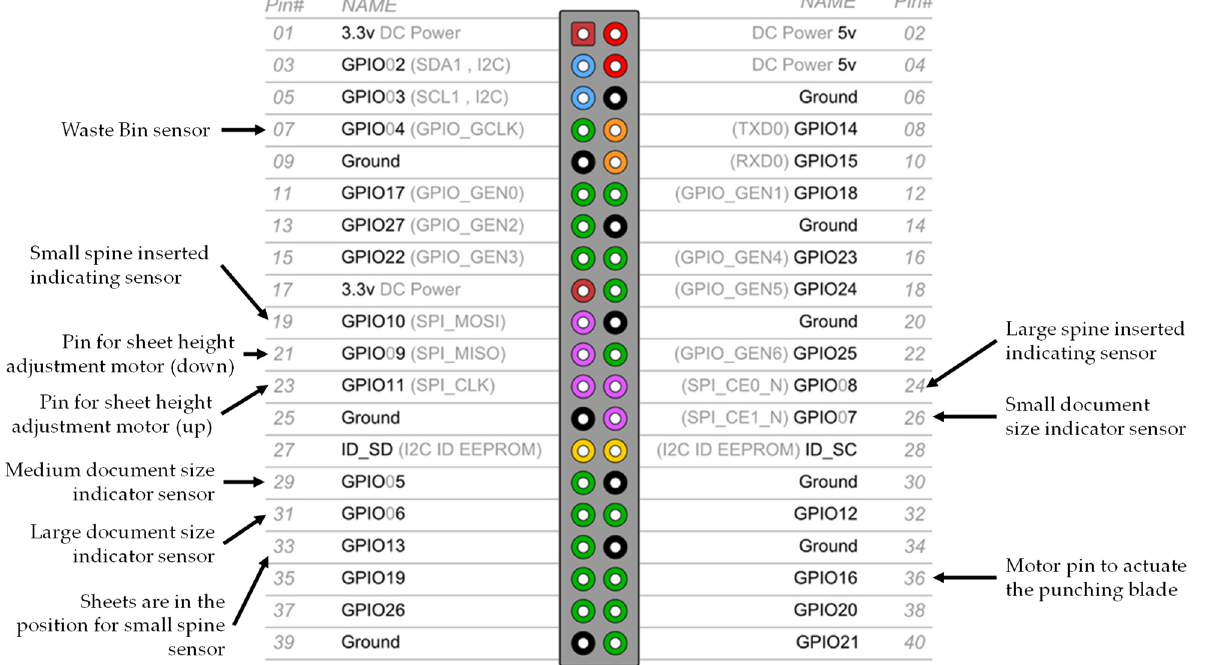
Table 1. Optical sensor characteristics.